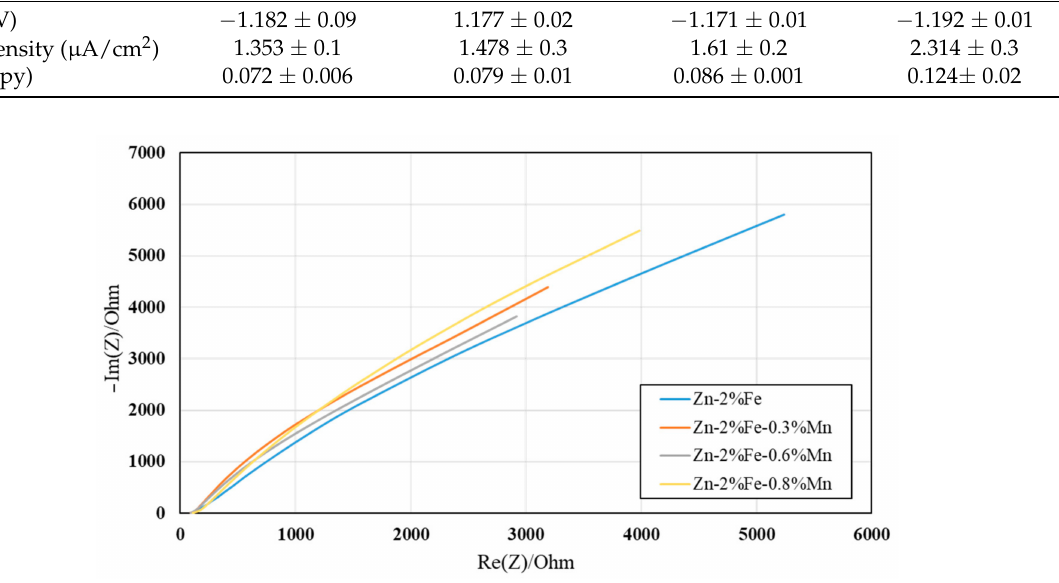
Figure 11. Impedance spectroscopy analysis of the tested alloys in PBS solution in terms of Nyquist